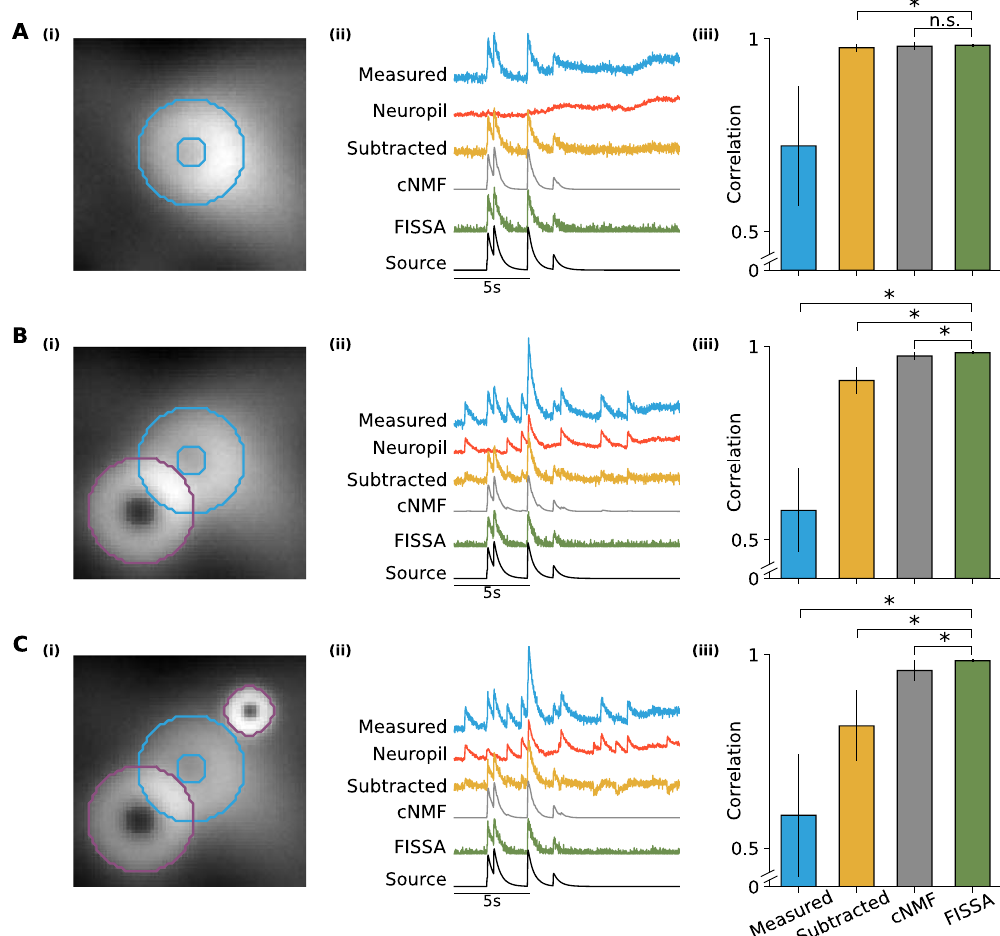
Figure 2. Comparison of FISSA performance with other decontamination methods on simulated calcium imaging data. Rows A , B , and C illustrate three cases with increasing levels of contamination. ( A )(i) Image of a region containing a single doughnut-shaped cell firing at 0.5 Hz and a fluctuating neuropil background. The image is an average across all 12000 frames (120 s). The ROI is indicated in blue. (ii) Example fluorescence traces for the blue ROI indicated in panel A(i): average measured signal of the ROI (blue trace, ‘Measured’), the average surrounding neuropil signal (red trace), and the signals after neuropil decontamination by three different methods (subtraction in yellow, cNMF in grey, and FISSA in green). The uncontaminated source signal (as defined by the simulation) is shown in black. The cNMF trace has a lower noise level as the cNMF algorithm also includes smoothing. (iii) Average Pearson correlations between the ROI source signal and the extracted ROI signal: before decontamination (first column, ‘Measured’, 0.723), and after each decontamination method (neuropil subtraction, cNMF, and FISSA; 0.977, 0.981, and 0.984 respectively). Error bars indicate standard deviation. * p < 0.05; ** p < 0.005; n.s.: not significant (p > 0.05); Wilcoxon signed-rank test, n = 10 simulations of 120 s each (with different background neuropil signals, spike times, and photon noise). FISSA vs: measured p = 0.0033, subtraction p = 0.0409, cNMF p = 0.0911. ( B ) As panel A, but the blue ROI is additionally contaminated by an overlapping cell firing at 0.3 Hz (indicated by the purple outline). Average values for the four methods are 0.576, 0.912, 0.975, and 0.984 respectively. FISSA vs: measured p = 0.0033, subtraction p = 0.0033, cNMF p = 0.0033. ( C ) As panel B, but an additional bright localized signal firing at 0.3 Hz was added (smaller purple outline). Average values for the four methods are 0.585, 0.816, 0.959, and 0.984 respectively. FISSA vs: measured p = 0.0051, subtraction p = 0.0051, cNMF p =